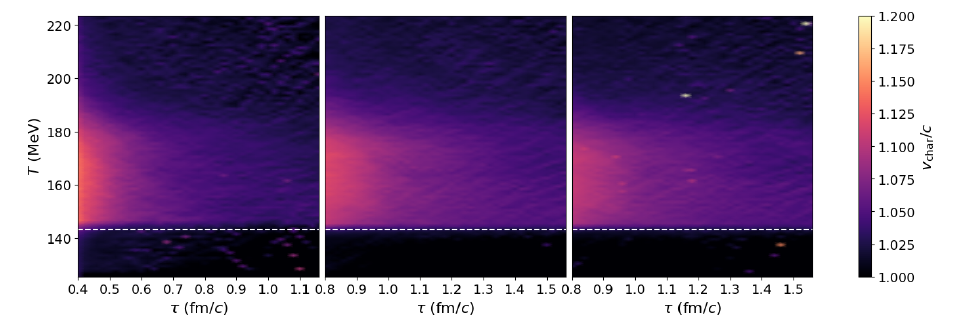
Figure 3. The momentum anisotropy ϵ 2 , p (left) and spatial eccentricity ϵ 2 , x (right) versus time. Black dots represent the points at which exactly half of the hydrodynamic cells ε (with ε FO ) become ≥ explicitly causal. Taken from Ref.